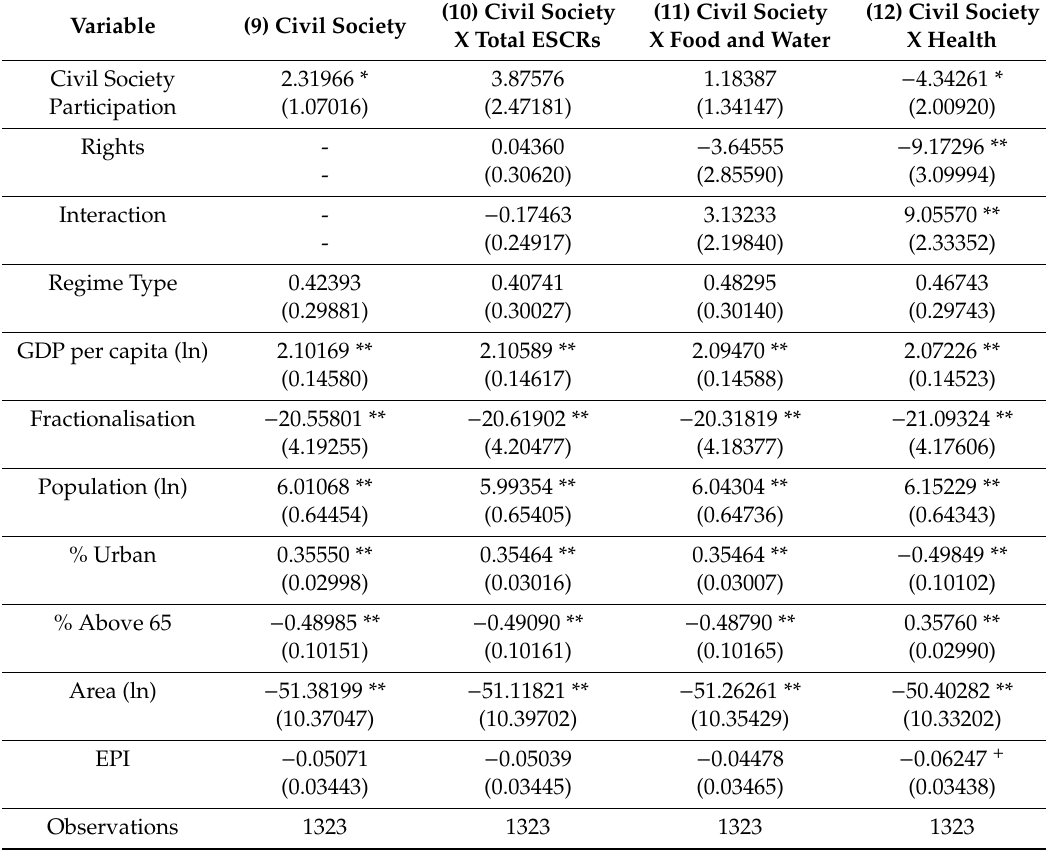
Table 4. Civil Society Participation, ESCRs, & Basic Water Access,